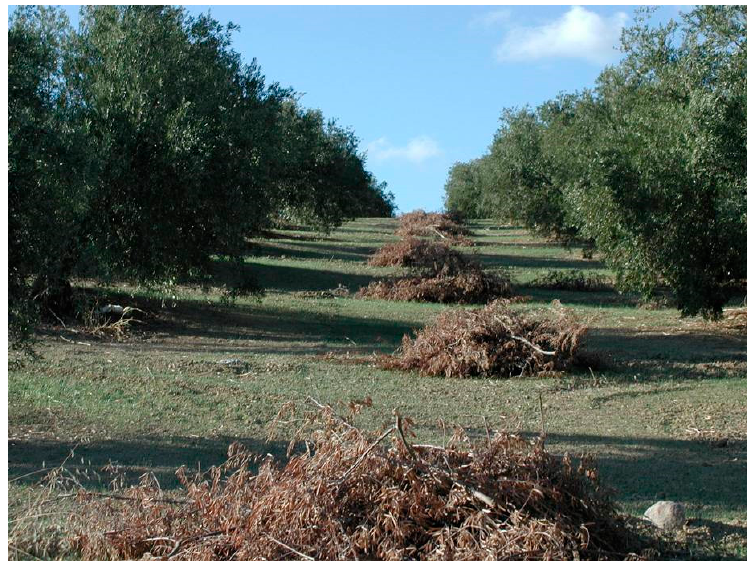
Figure 5. Olive-tree pruning piled up in the field.